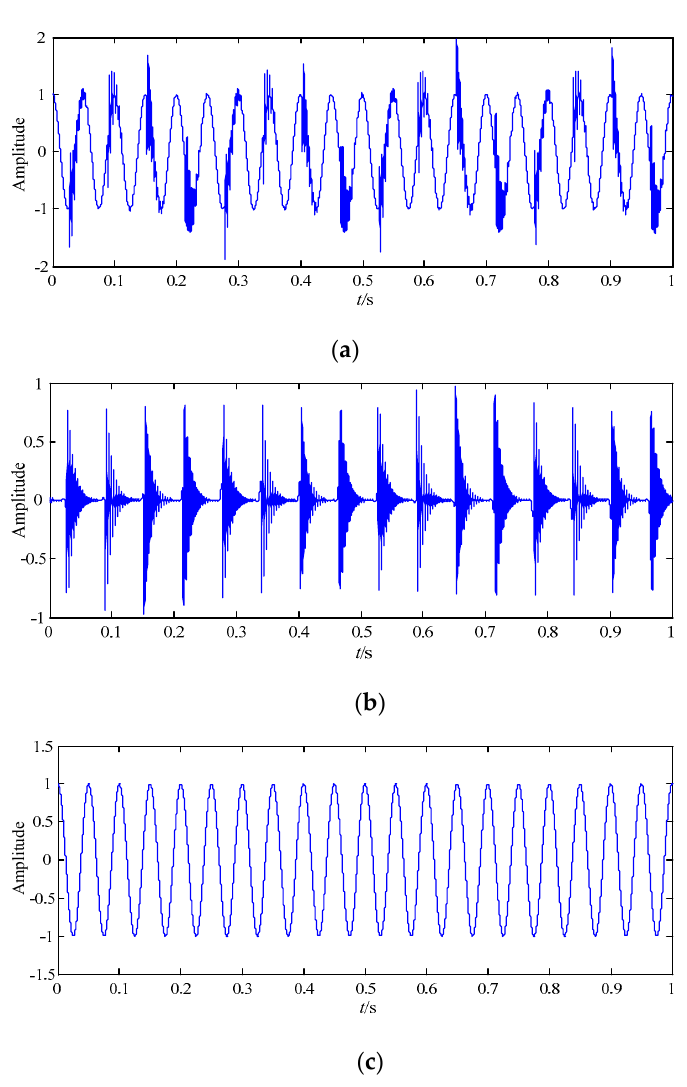
Figure 4. The time domain wave of the simulated signal. ( a ) x ( t ); ( b ) x 1 ( t ); ( c ) x 2 ( t ).